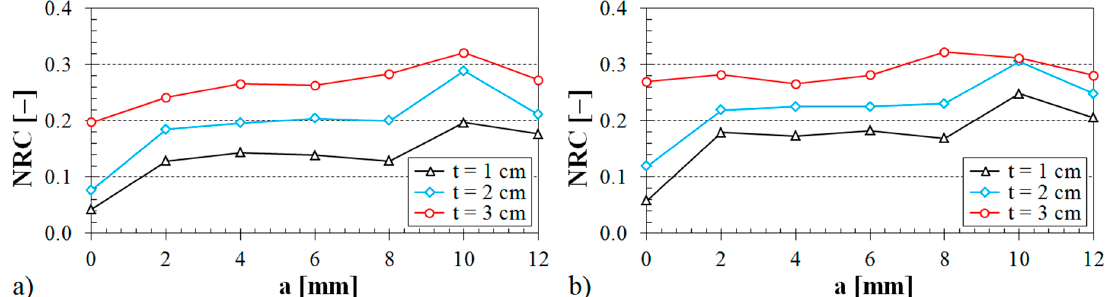
Figure 9. Influence of the material thickness on the noise reduction coefficient vs. air space size for the tested ABS samples: ( a ) Octagonal structure, volume ratio V r = 44%; ( b ) Cartesian structure, volume ratio V r = 57%.